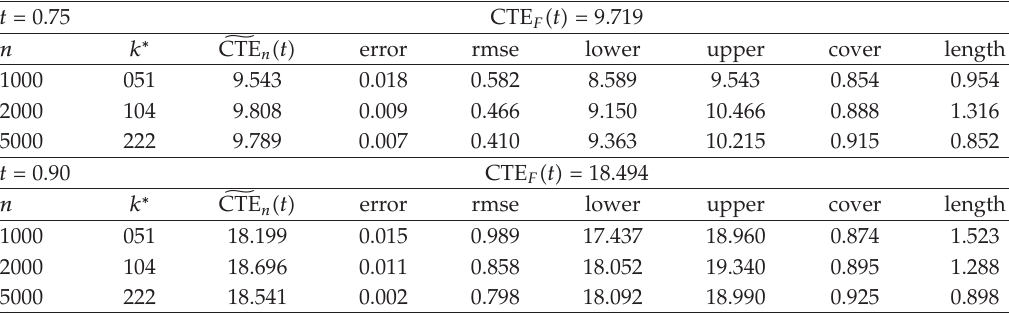
(cid:8) Table 2: Point estimates CTE n (cid:2) t (cid:3) and 95% confidence intervals for CTE F (cid:2) t (cid:3) when γ (cid:7) 3 / 4. t (cid:7) 0 .